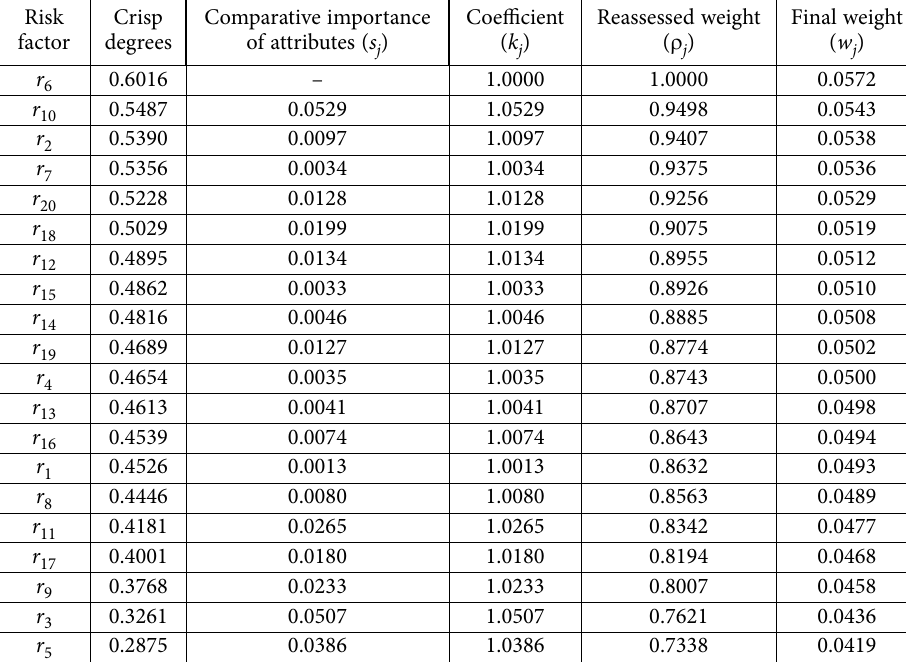
Table 6. Significance degree of IoT risks for supply chain management using SWARA